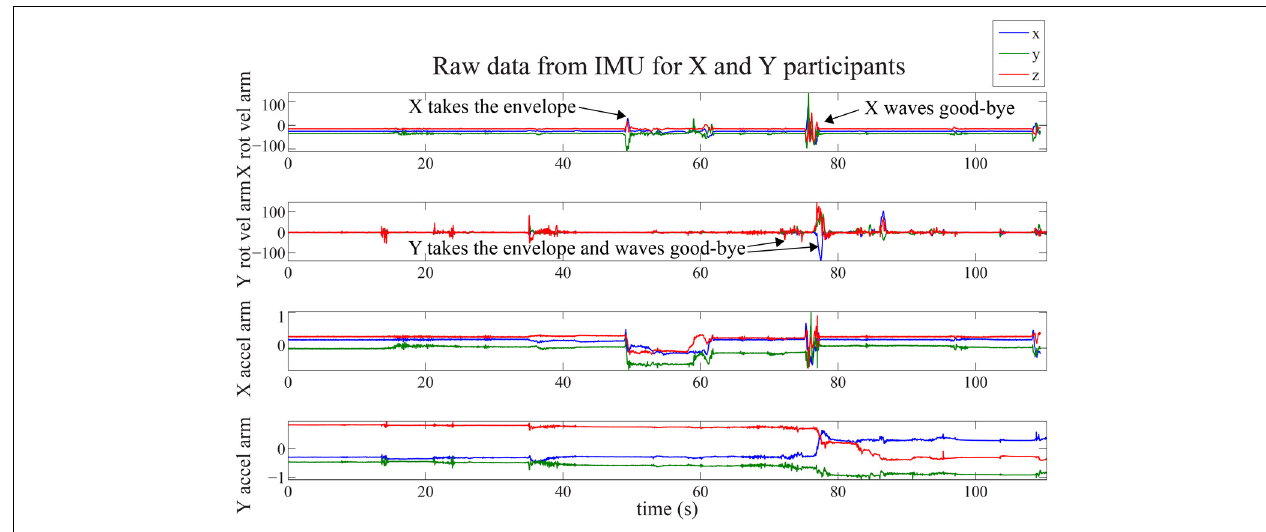
FIGURE 2 | Raw motion data collected with the IMU of the arm for both participants (rotational velocity in deg.s − 1 and linear acceleration in m.s − 2 ).